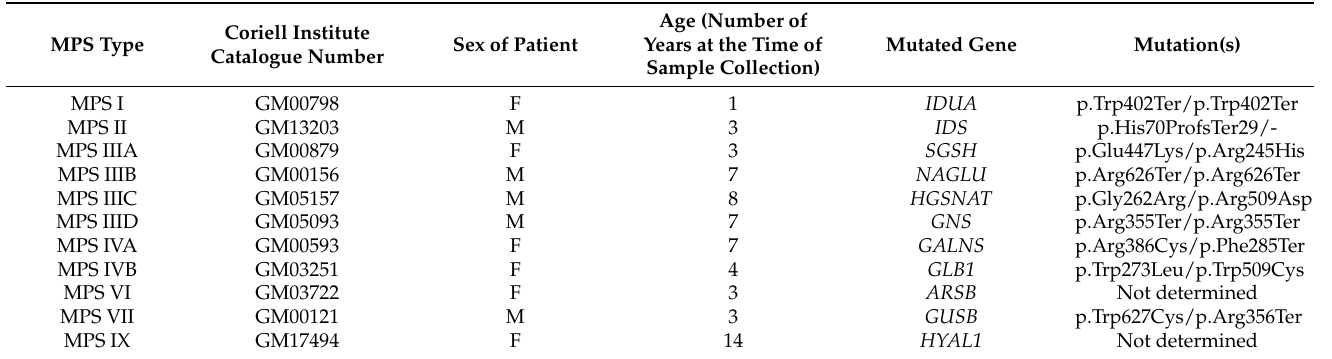
Table 1. Fibroblast lines derived from MPS patients and used in this